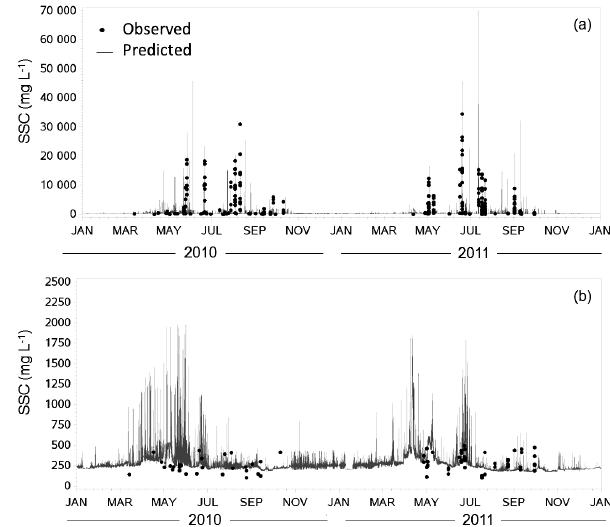
Figure 3. Observed and predicted sediment concentrations (in mgL − 1 ) for Location 3 in the irrigation channel (a) , and zooming in on base flow, showing only non-event samples and concentration predictions (b)